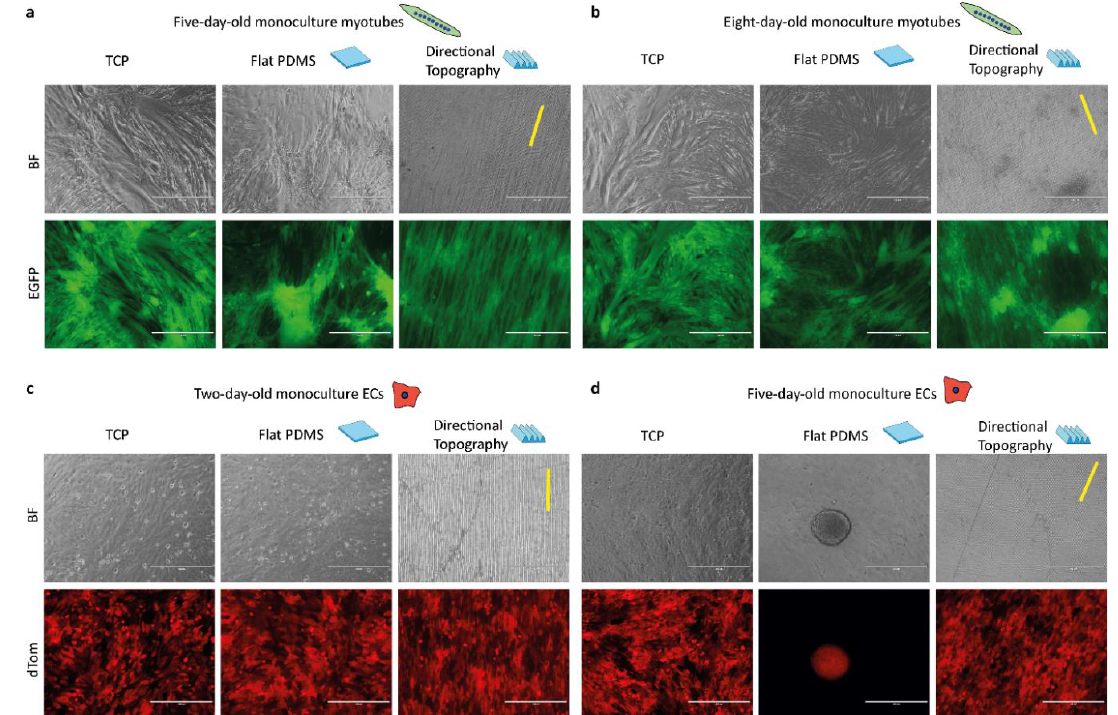
Figure 3. Topography influences cell alignment and attachment of ECs. Life cell imaging micrographs of control monocultures of myotubes after five ( a ) and eight days ( b ) of differentiation and ECs after two days ( c ) and five days ( d ) of culture on the different surfaces, with TCP, flat, and directional (indicated with yellow line) topography. Time points correspond to the timeline of the co-culture, which had three-day-old preformed myotubes. Myotubes are EGFP-tagged (green) and ECs are dTomato-tagged (red). Scale bars are 400 µm.